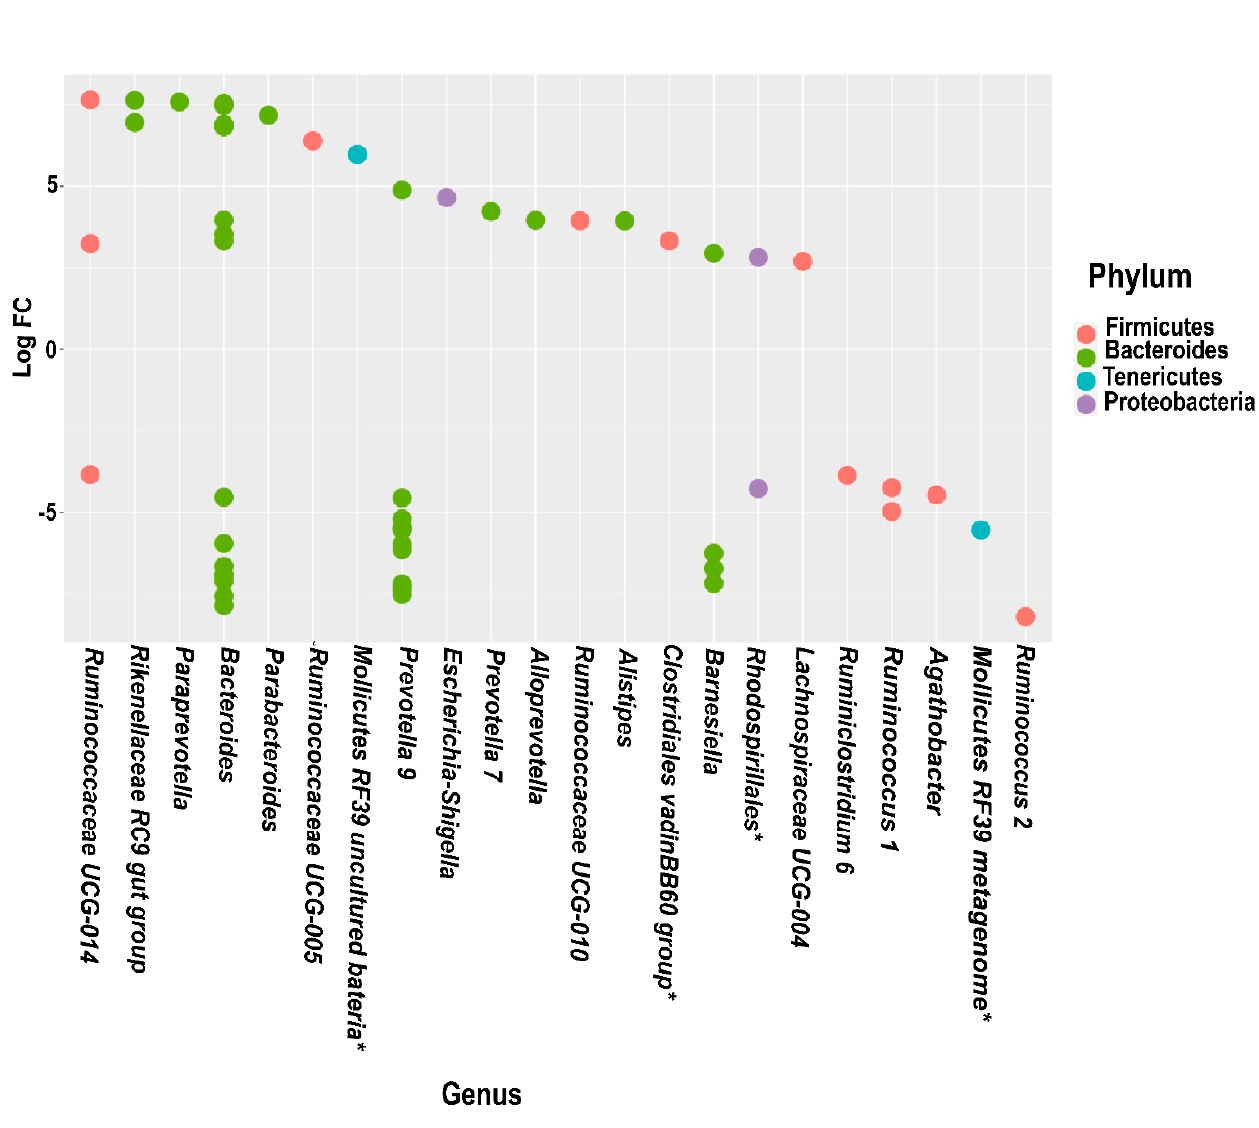
Figure 1. Log2-fold-change of the relative abundance of individual operational taxonomic units of